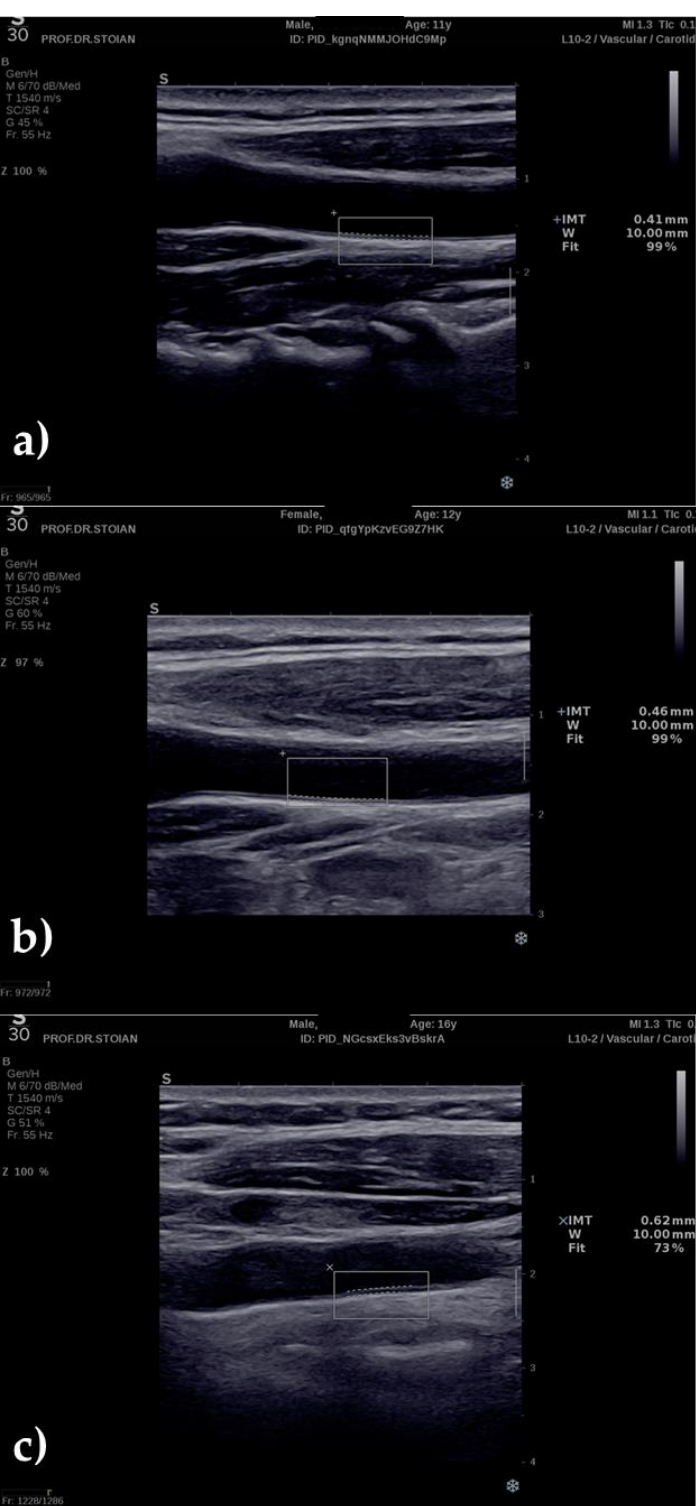
Figure 1. Examples of CIMT measurements. ( a ) an 11-year-old normal-weight boy. ( b ) a 12-year-old overweight girl. ( c ) a 16-year-old obese boy.